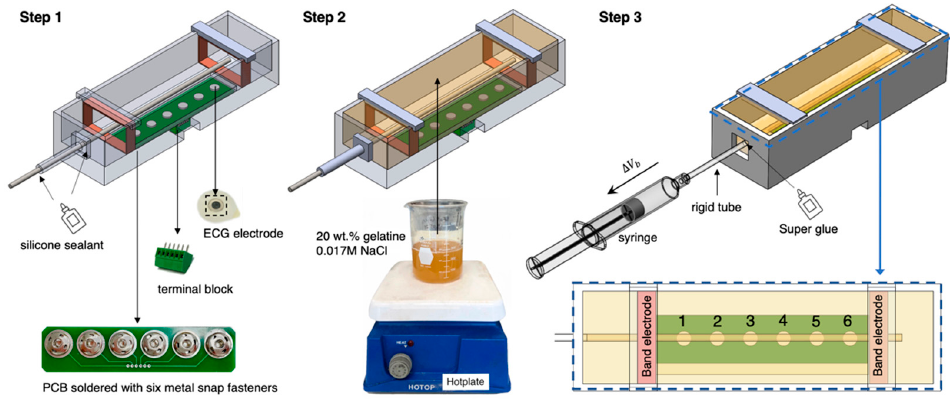
Figure 6. The whole fabrication process of the wrist phantom.